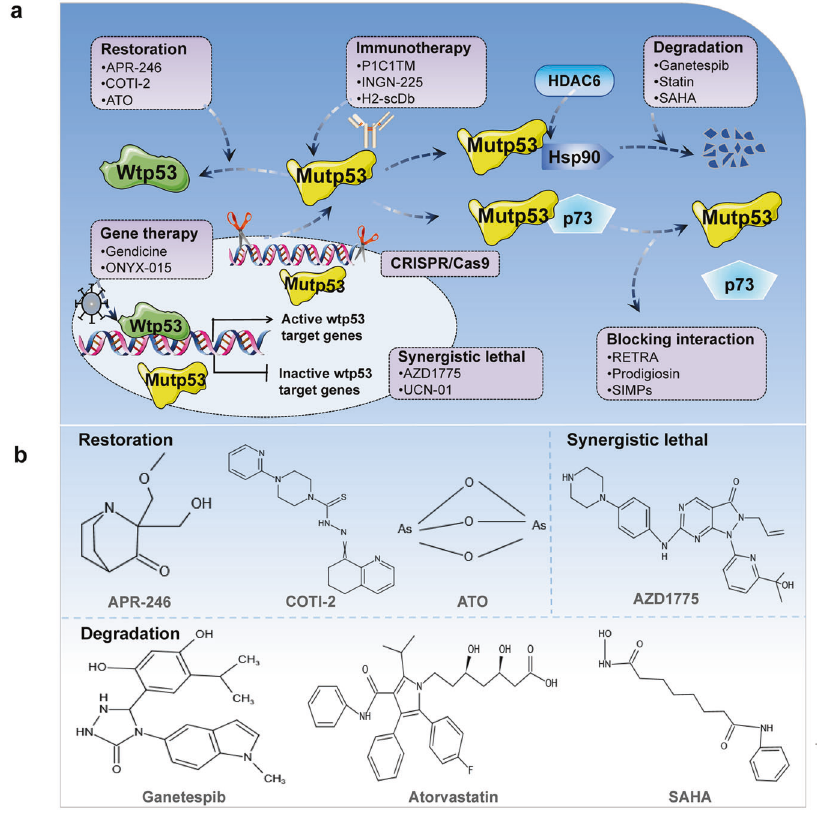
Fig. 7 Schematic representation of the mechanism of targeting mutp53 for tumor therapy. a Treatment strategies for tumor cells carrying mutp53. b Chemical structures of common drugs used in clinical